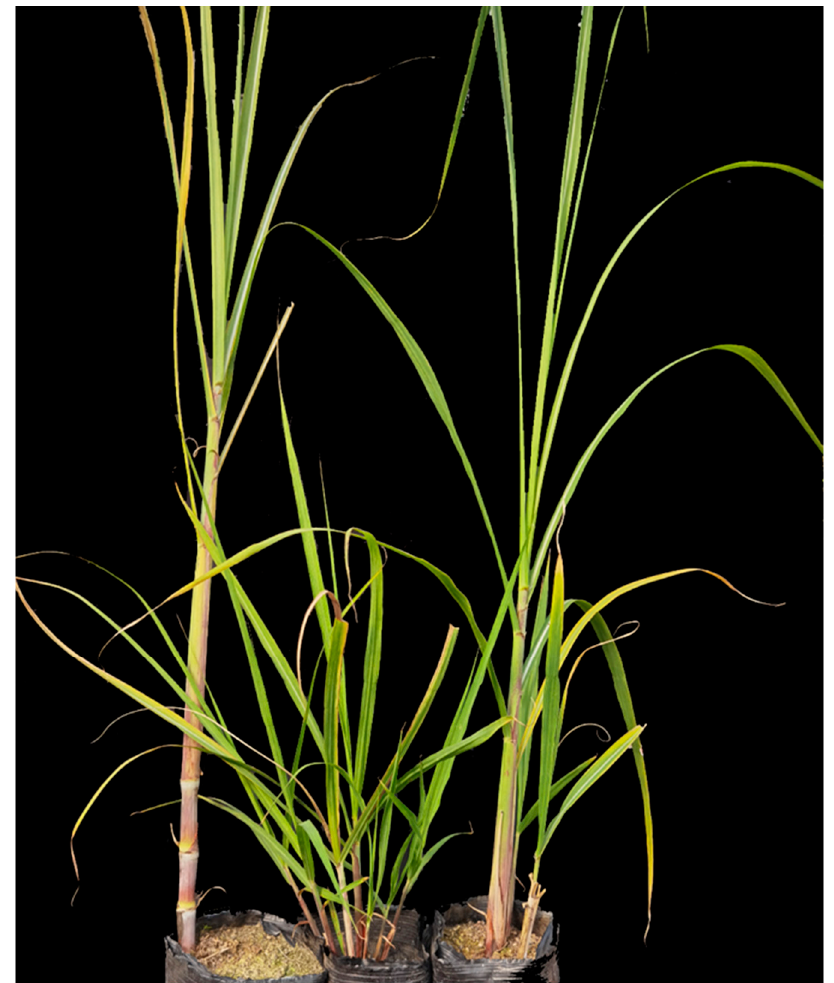
Figure 6. Images of plant phenotypes. ScD27.2F-2 sense overexpression lines, ScD27.2R-9 antisense interference lines, and non-transgenic control lines (NT) are shown left to right.